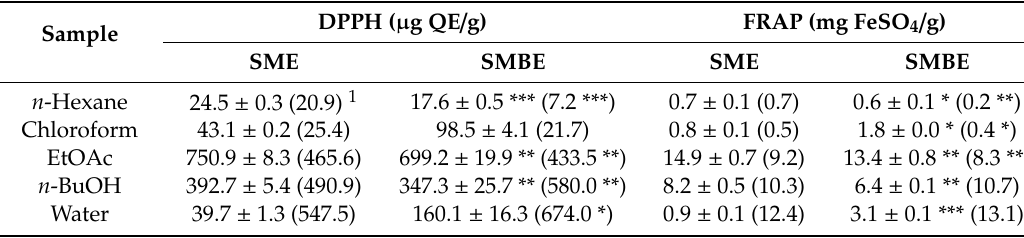
Table 2. Antioxidant activities of each solvent fraction of SME and